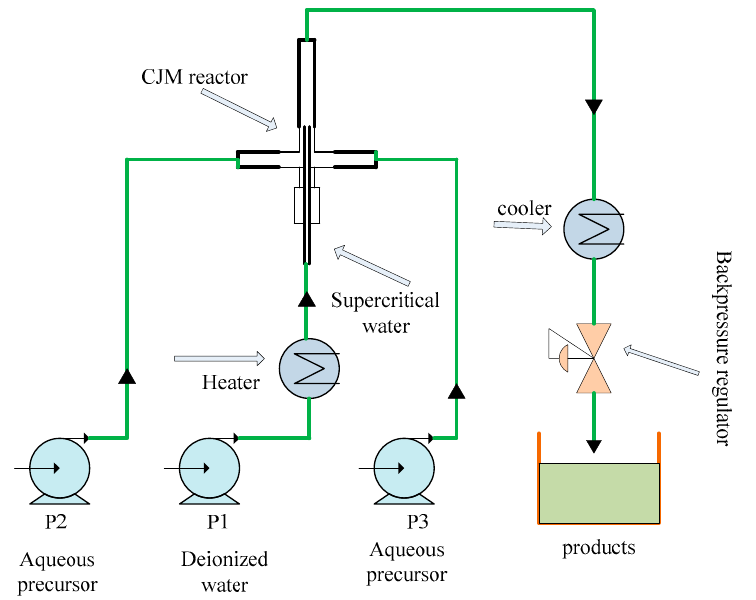
Figure 1. Flow diagram of the continuous hydrothermal flow synthesis process with confined jet mixer. CJM: confined jet mixer.